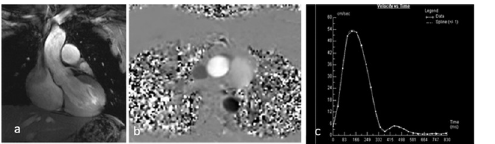
Fig 7. Flow measurements. a) Left ventricular outflow tract, and b) phase encoded view of the aorta. c) Flow curve derived from the flow measurements. The x-axis shows the time in ms, the y-axis the measured aortic flow in